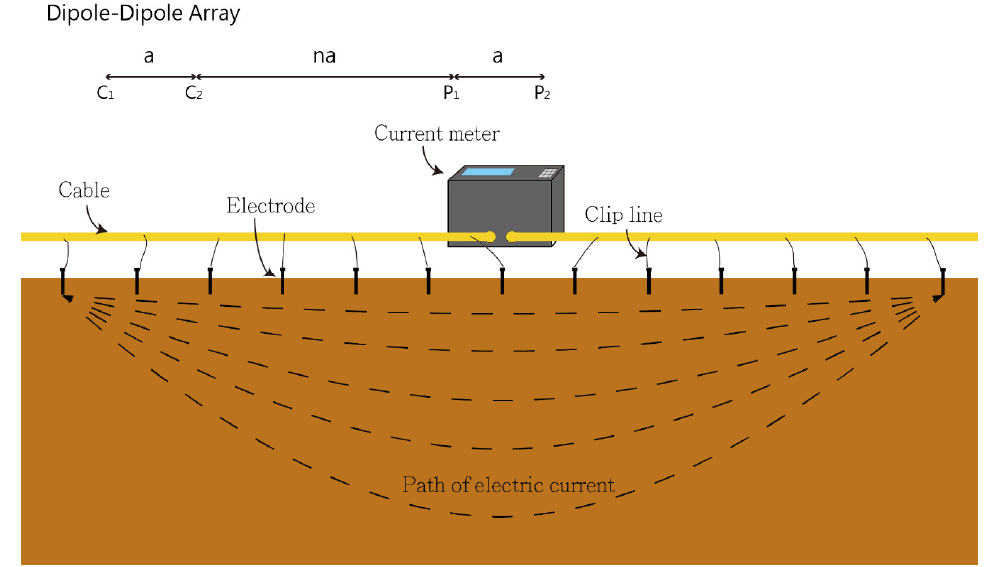
Figure 1. Schematic diagram of the ERT test.